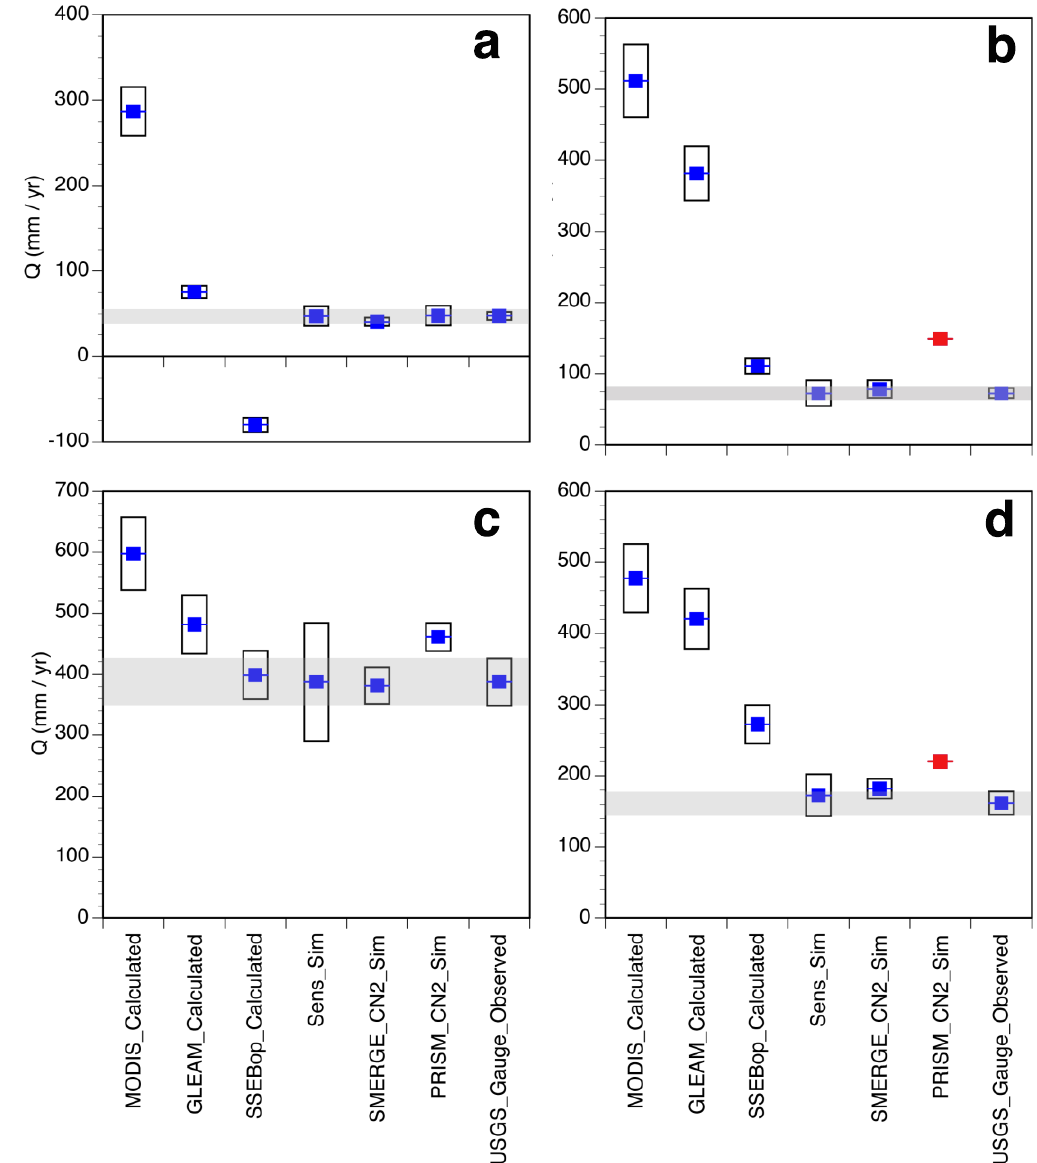
Figure 10. Same as Figure 5, except red symbol indicates an unacceptable simulation (RPS < 1.00). ( a ) NI-2016, ( b ) NI-2018, ( c ) WN-2016, and ( d ) WN-2018.